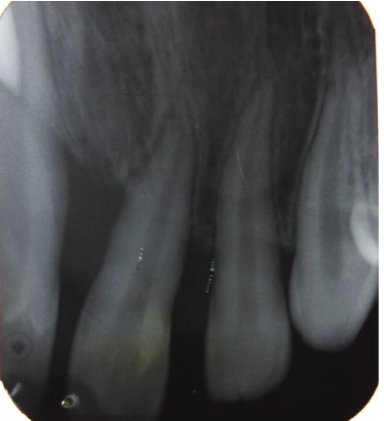
Figure 8: Intraoral periapical radiograph showing bone loss in relation to 11, 12.